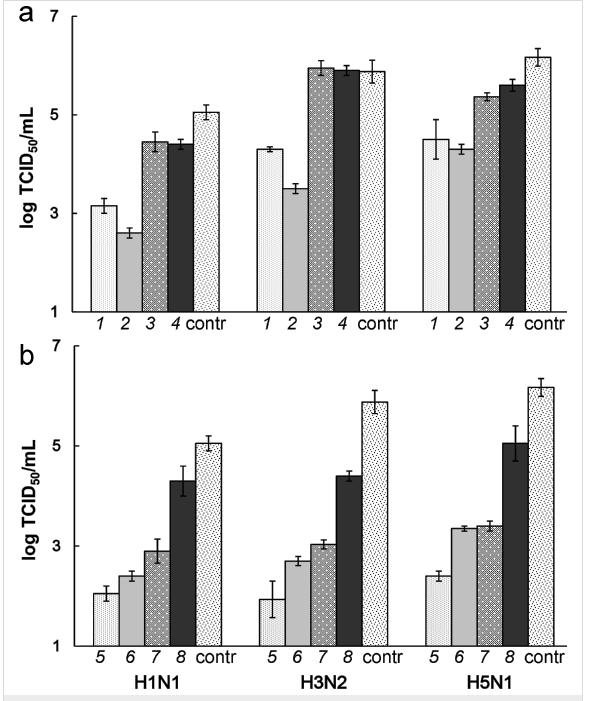
Figure 2: IAV titers in MDCK cells infected with H1N1, H3N2, and H5N1 IAV subtypes and treated with TiO 2 ·PL–DNA nanocomposites containing DNA 1 –DNA 8 fragments (columns 1–8, respectively). The location of these fragments on IAV strands can be seen in Figure 1. The nanoparticle concentration was 5 μ g/mL and the DNA fragment concentration was 0.1 μ M (20 nmol/mg). The values are mean values